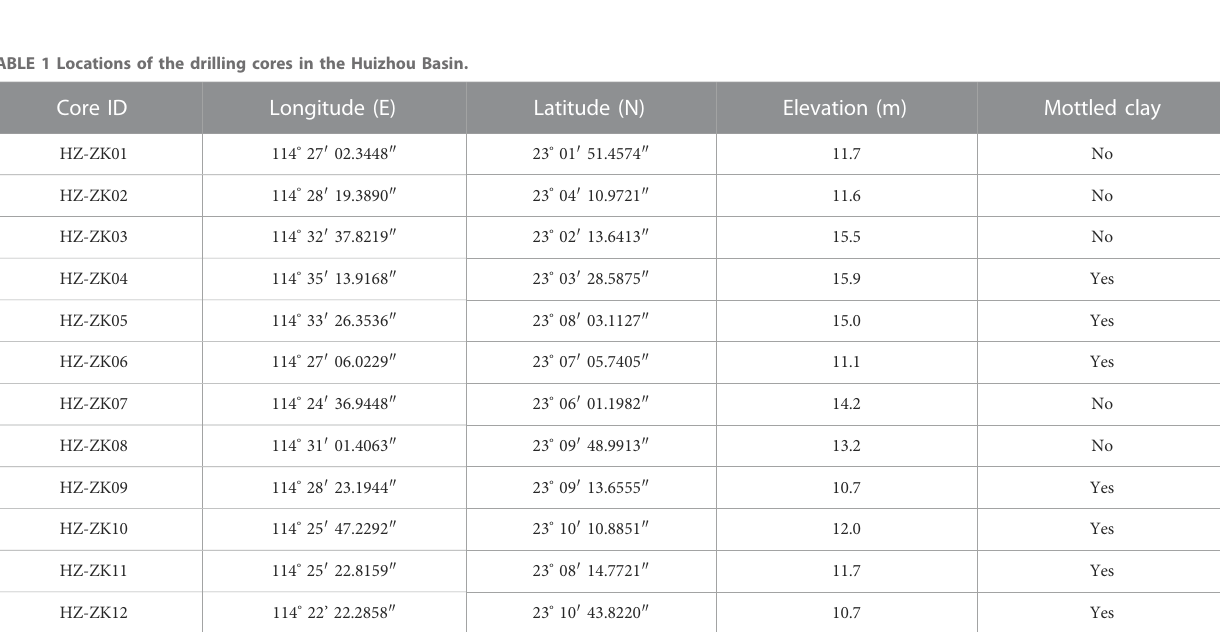
fl ame-like vertical structures intruding into yellow/red sediments (Figure 3B). The deformation features were clearly distinguished from the underlying loess-like silt or fl uvial sand deposits (Figure 3). The normal aeolian sediment is homogeneous in color and grain size (Figure 3A), and fl uvial sand deposits present pronounced horizontal features (e.g., laminae).